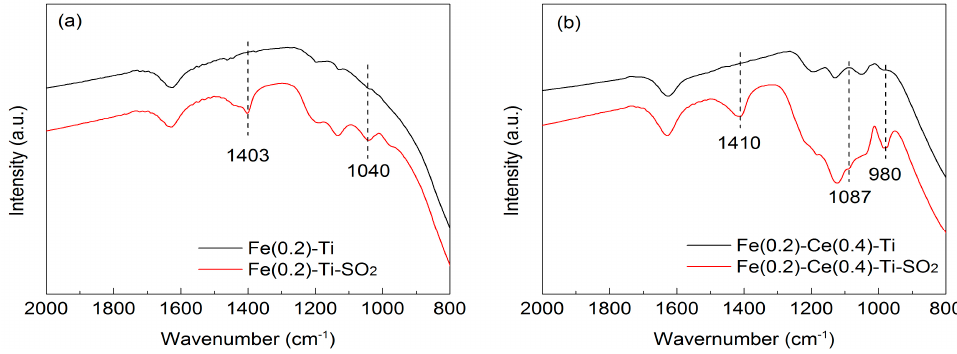
Figure 12. FT ‐ IR spectra of the fresh and used catalyst: ( a ) Fe(0.2)–Ti and ( b ) Fe(0.2)–Ce(0.4)–Ti.